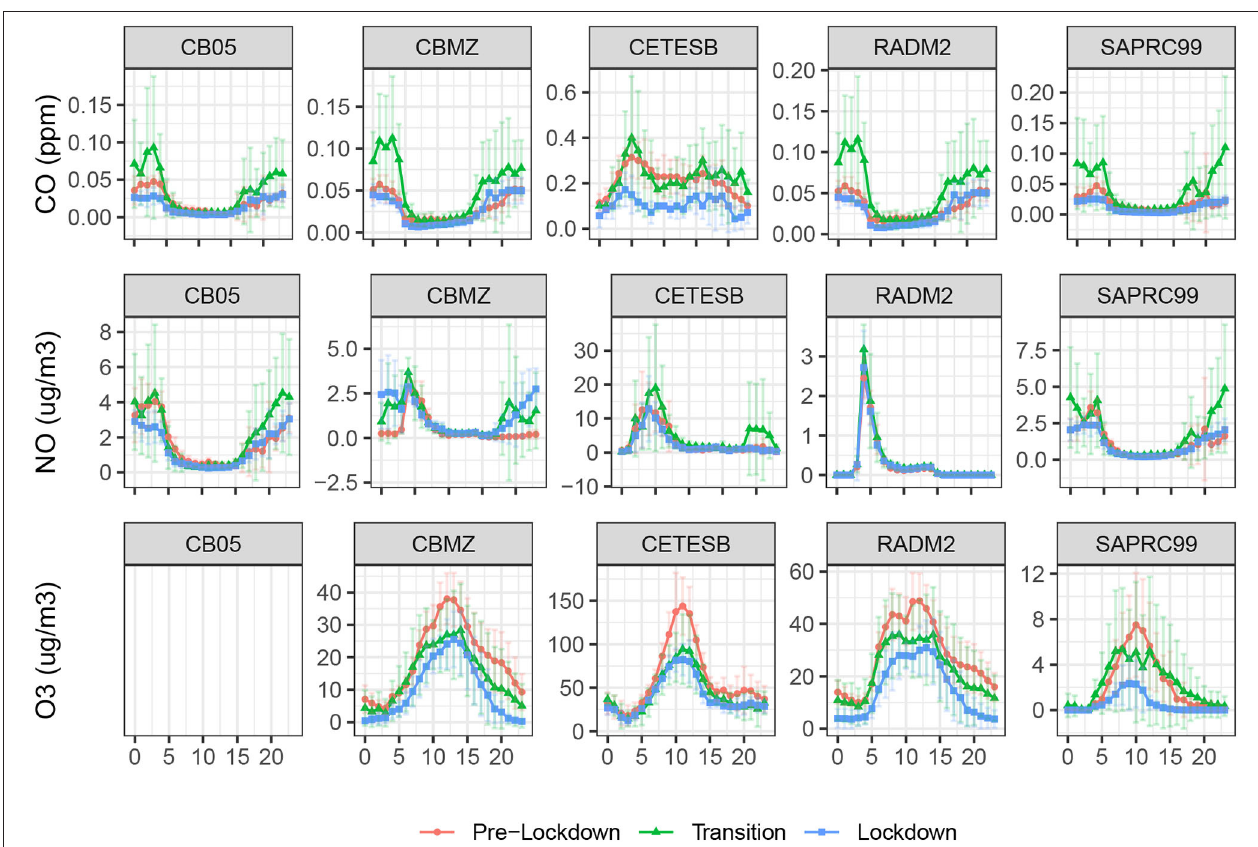
FIGURE 5 | Simulated diurnal cycle during Lockdown periods in March 2020 São Paulo for the chemical mechanisms CB05, CBMZ, RADM2, SAPRC99, and observations from CETESB. The points represent the averages and the vertical lines, the standard deviation.